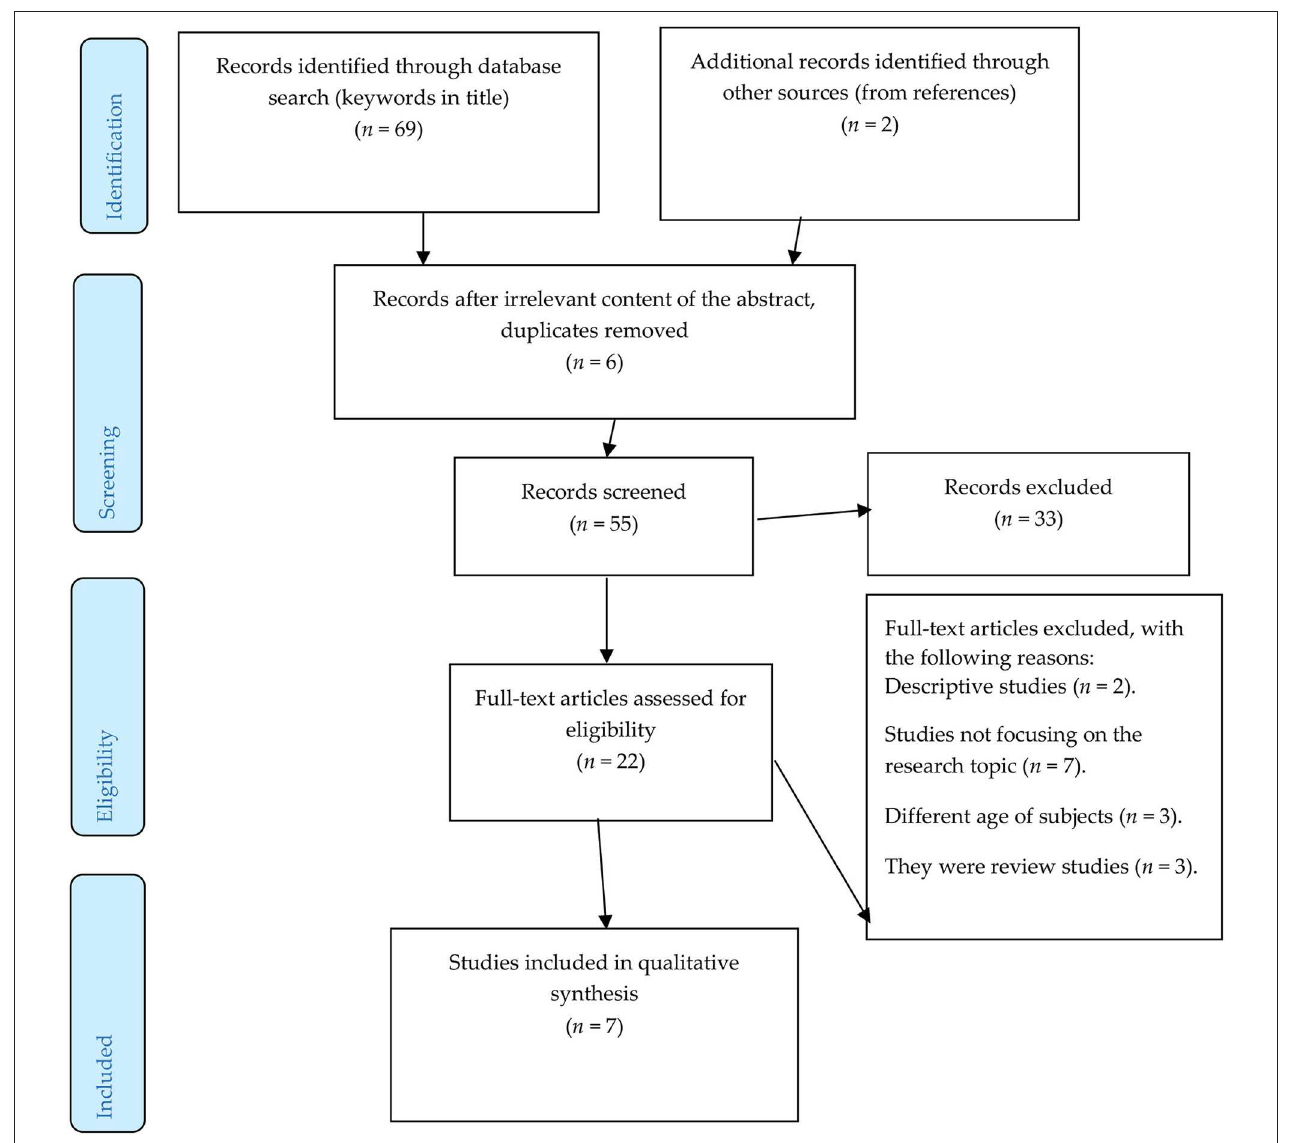
FIGURE 1 | An overview of the selection